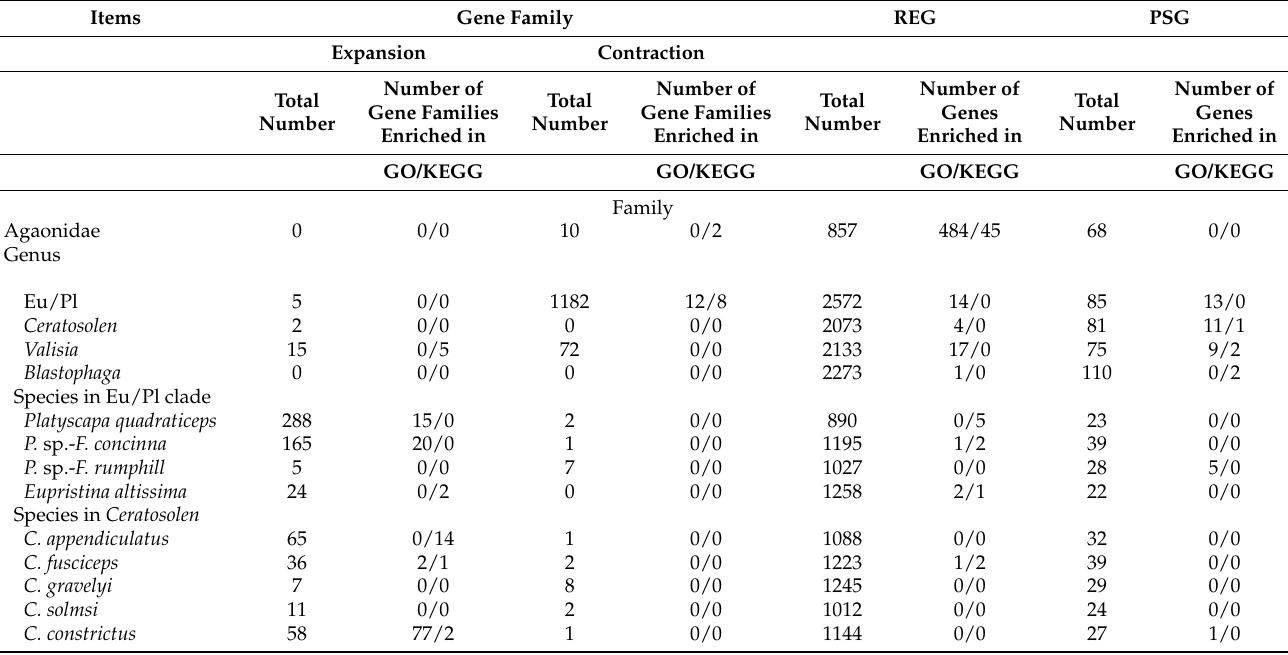
Table 2. Numbers of gene family expansions/contractions, rapidly evolving genes (REGs), and positively selected genes (PSGs) and the numbers of genes enriched in GO/KEGG according to family, genus, species, and related species/taxa of fig wasps given in the phylogenetic